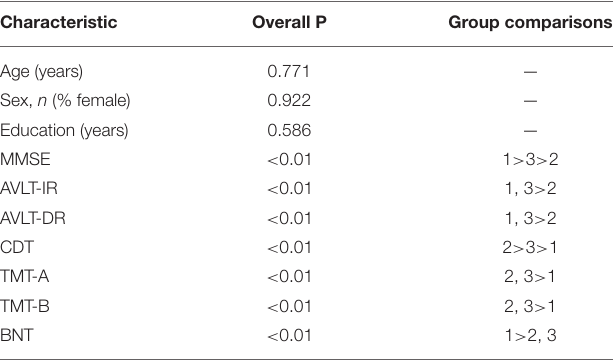
TABLE 2 | Comparisons of the clinical characteristics of the three groups.